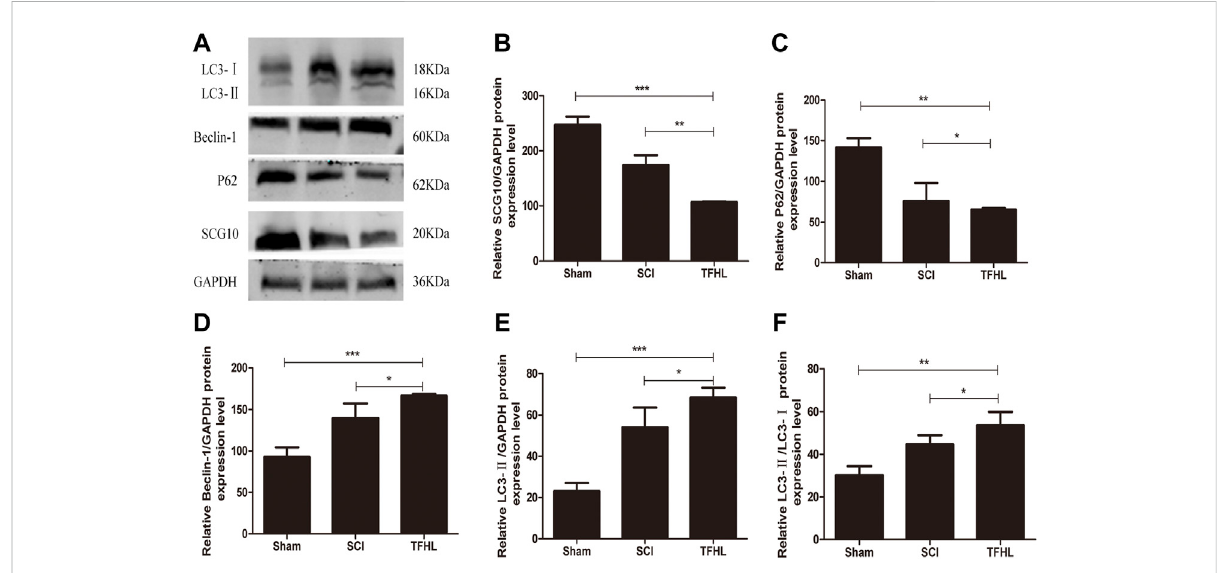
FIGURE 7 TFHL in fl uences axons and autophagy related proteins expression in injured spinal cord tissues. (A) The expression of axon and autophagy- related protein in spinal cord tissues of rats in each group was assessedby Western blot assay. (B – F) The comparison of relative densitometry values between each group. All data are expressed as the mean ± SD. Differences among groups were determined with one-way ANOVA followed by a least-signi fi cant difference post hoc test. n = 6 per each group, * p < 0.05, ** p < 0.01, *** p <